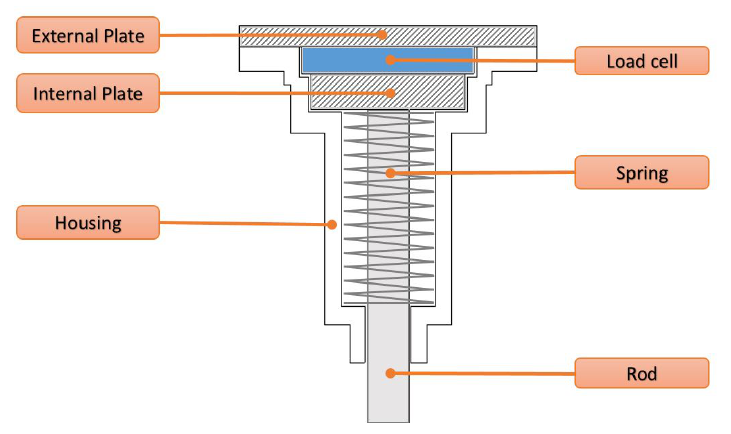
Figure 3. Detailed drawing of the custom-made load cell installation.